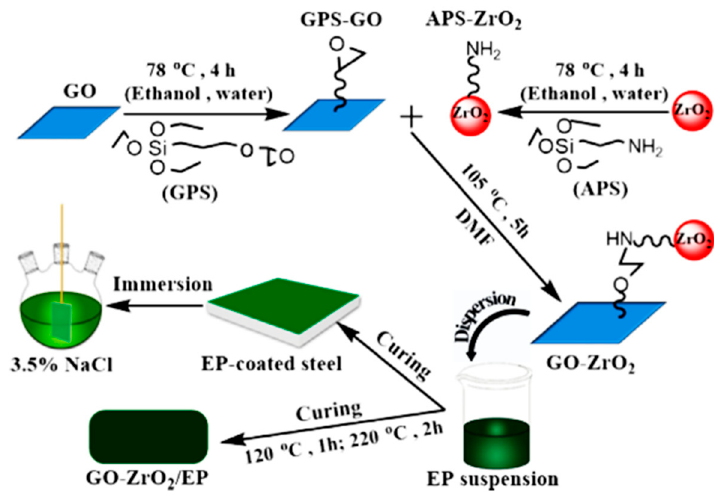
Figure 19. Schematic of preparation of GO–ZrO 2 and the corresponding hybrid coatings [129].